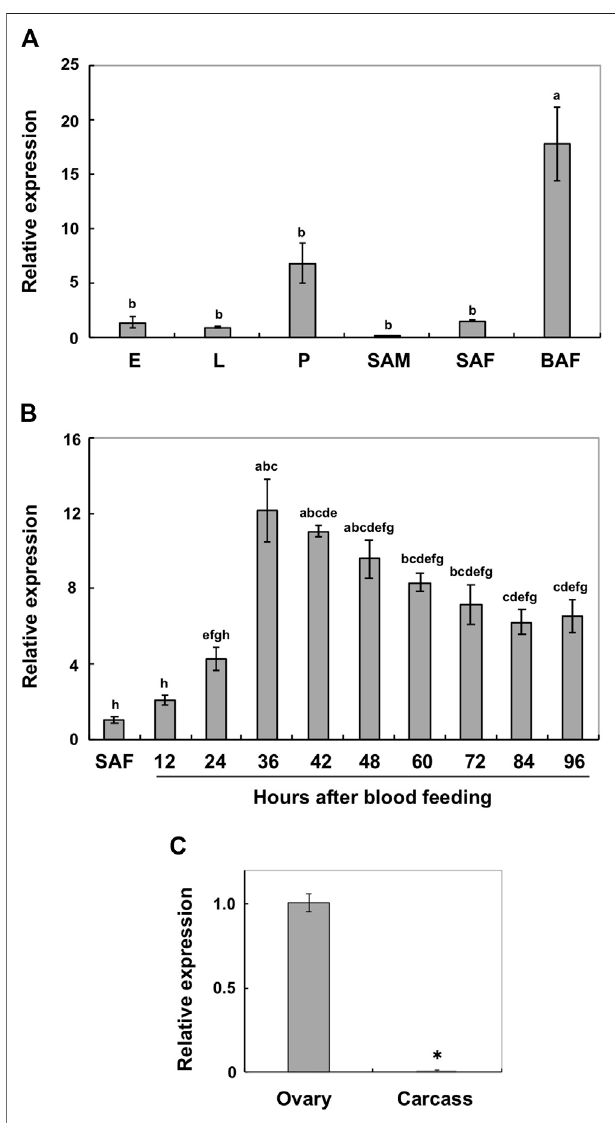
FIGURE 2 | Expression pro fi les of AalY-y by real-time PCR. Transcript levels of AalY-y relative to that of Ae. albopictus ribosomal protein S6 ( AalRpS6 ) were determined by real-time PCR. Data are shown as the mean values ± SE (n (cid:1) 3). (A) Expression patterns of AalY-y during development. E, eggs; L, larvae; P, pupae; SAM, sugar-fed adult males; SAF, sugar-fed adult females; BAF, blood-fed adult females (36 – 48 h post blood meal). Expression levels for AalY-y are presented relative to the levels of expression in the eggs (E). Different letters above each bar indicate signi fi cant differences ( p < 0.05, Tukey HSD test). (B) Induction patterns of AalY-y in response to a blood meal. Total RNA was isolated from SAF and BAF 12, 24, 36,42,48,60,72,84and96 hafterbloodfeeding.Expressionlevelsfor AalY- y are presented relative to the levels of expression in the sugar-fed adult females (SAF). Different letters above each bar indicate signi fi cant differences ( p < 0.05,TukeyHSDtest). (C) Toanalyzetissue-speci fi cexpressionof AalY-y in adults, total RNA was extracted from ovaries of 48 h post blood-fed females. The remaining tissues (whole body minus ovary) were pooled as the carcass. Expression levels for AalY-y are presented relative to the levels of expression in the ovaries. An asterisk indicates a signi fi cant difference in transcript levels of AalY-y ( p (cid:1) 0.006, t -test) between samples.